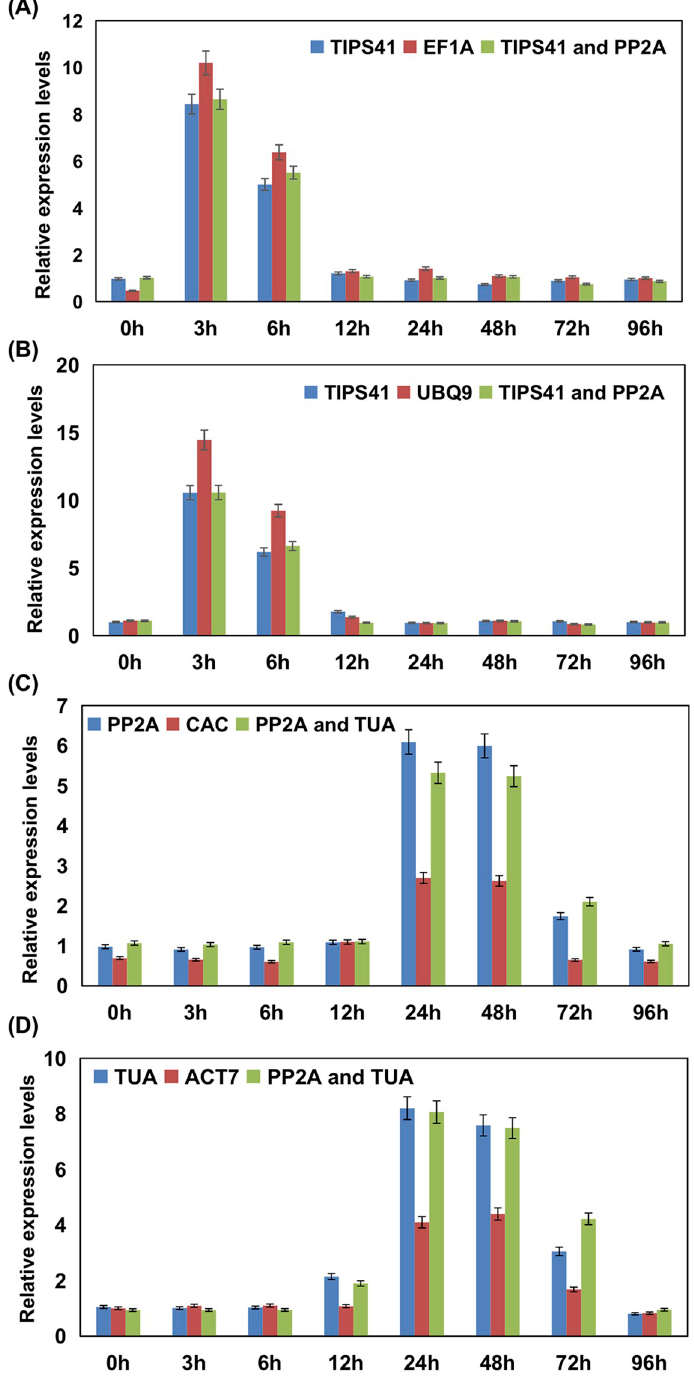
Fig 5. Validation of the identified reference genes. Relative quantification of PDF1 . 2 in JA treated samples of (A) B . juncea (B) C . sativa and A . brassicae inoculated samples of (C) B . juncea (D) C . sativa using one most stable, one least stable and two most stable reference genes identified in respective treatment groups.